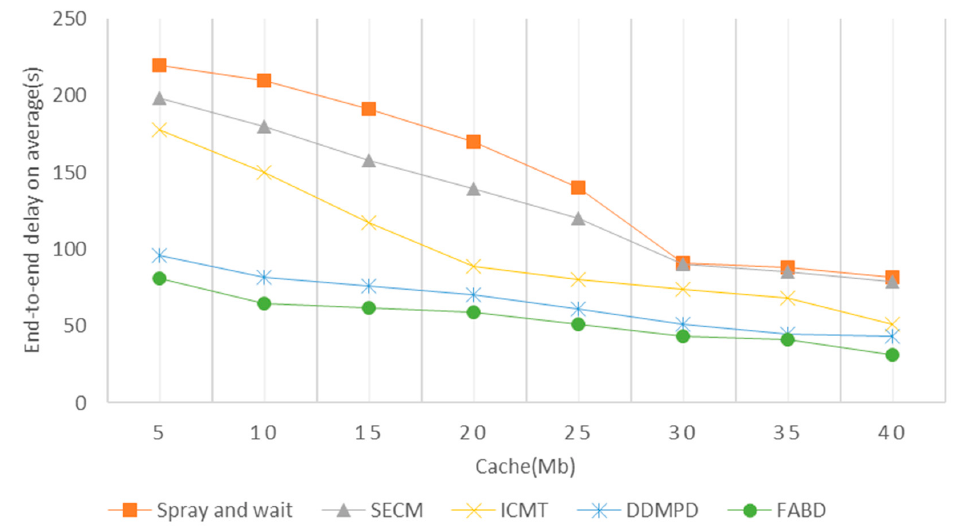
Figure 11. The relationship between the end-to-end delay and the cache.